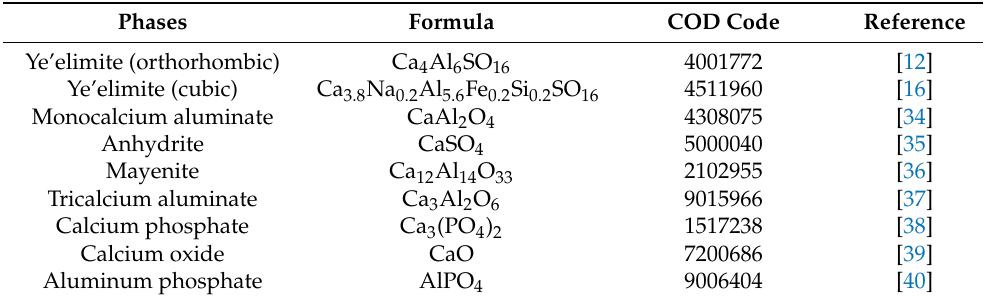
Table 2. COD codes and references of phases involved in Rietveld